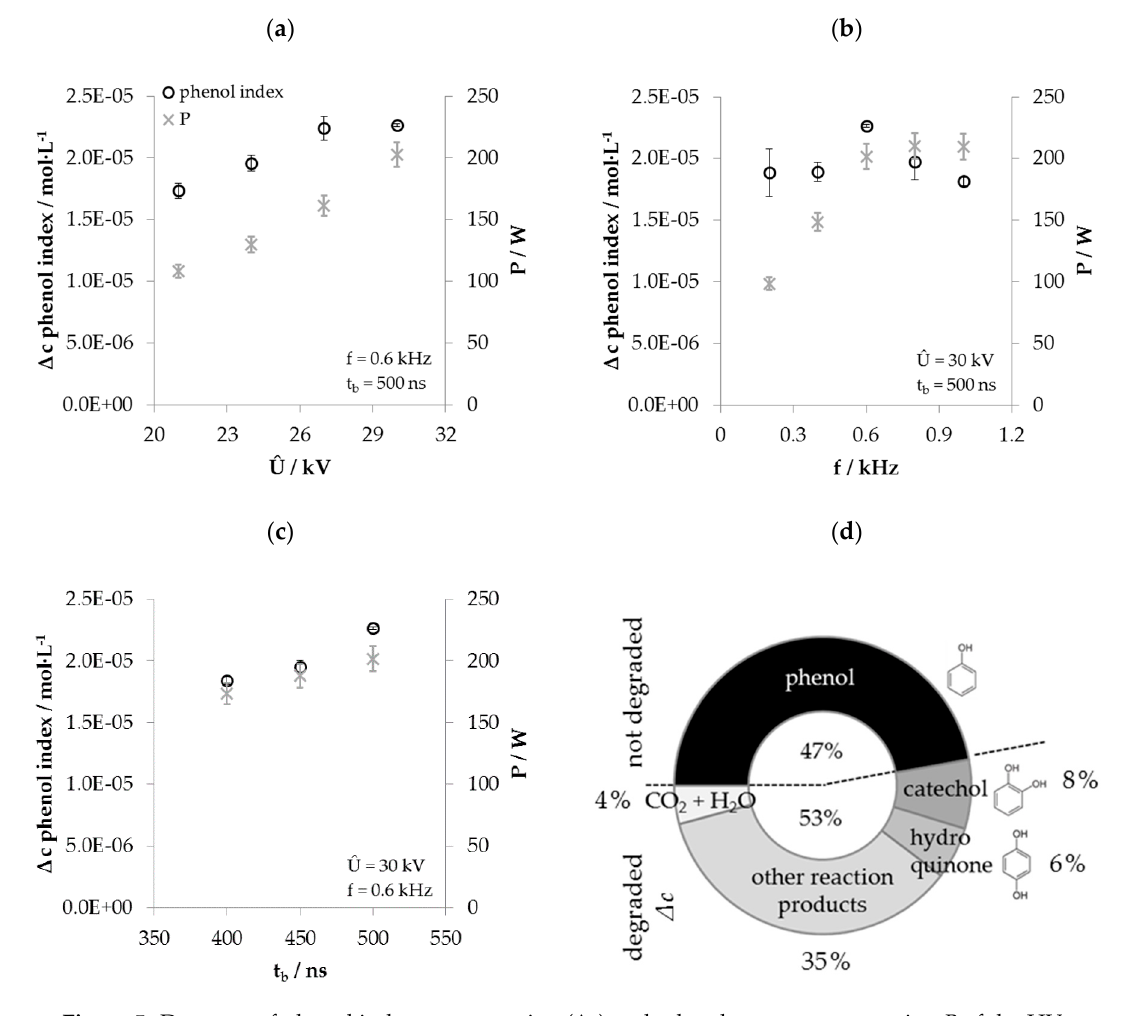
Figure 5. Decrease of phenol index concentration ( ∆ c ) and related power consumption P of the HV generator as a function of ( a ) voltage amplitude Û , ( b ) pulse repetition rate f , and ( c ) pulse duration t b and ( d ) relative stoichiometric composition of the quasi-sum parameter phenol index after water treatment.